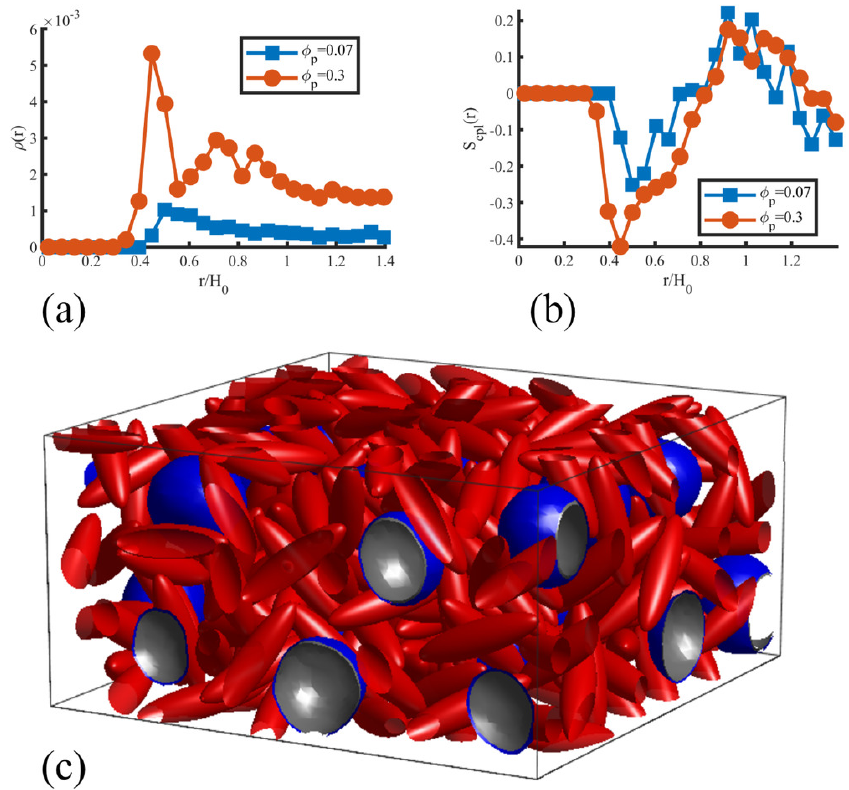
Figure 19. Orientational and translational assembly of 3D ellipsoidal NPs with anisotropy e = 1/4 in a BCC sphere forming BCP with f 0 = 0.7. NPs are miscible in the majority (continuous) phase. ( a , b , respectively, show the curves for the particle density φ p and coupling nematic order parameter S cpl ( r ) with respect to the radial vector to the center of BCP domains in function of the distance r to the center of BCP domains). In ( c ) a snapshot of a dense simulation φ p = 0.3 is shown, with NPs shown in red and the isosurfaces of the BCP interface shown in blue and grey. Reprinted with permission from Advanced Theory and Simulations, 2022, 5(1), 2100433 [170] Copyright 2022